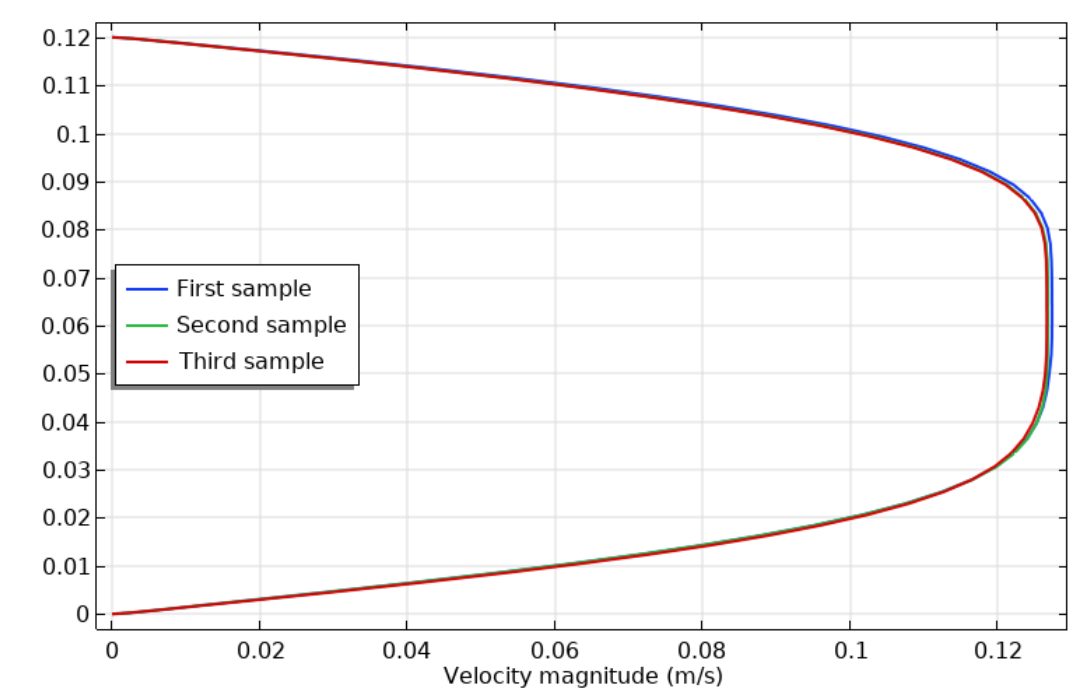
Figure 17. Nusselt number in the channel–enclosure assembly.